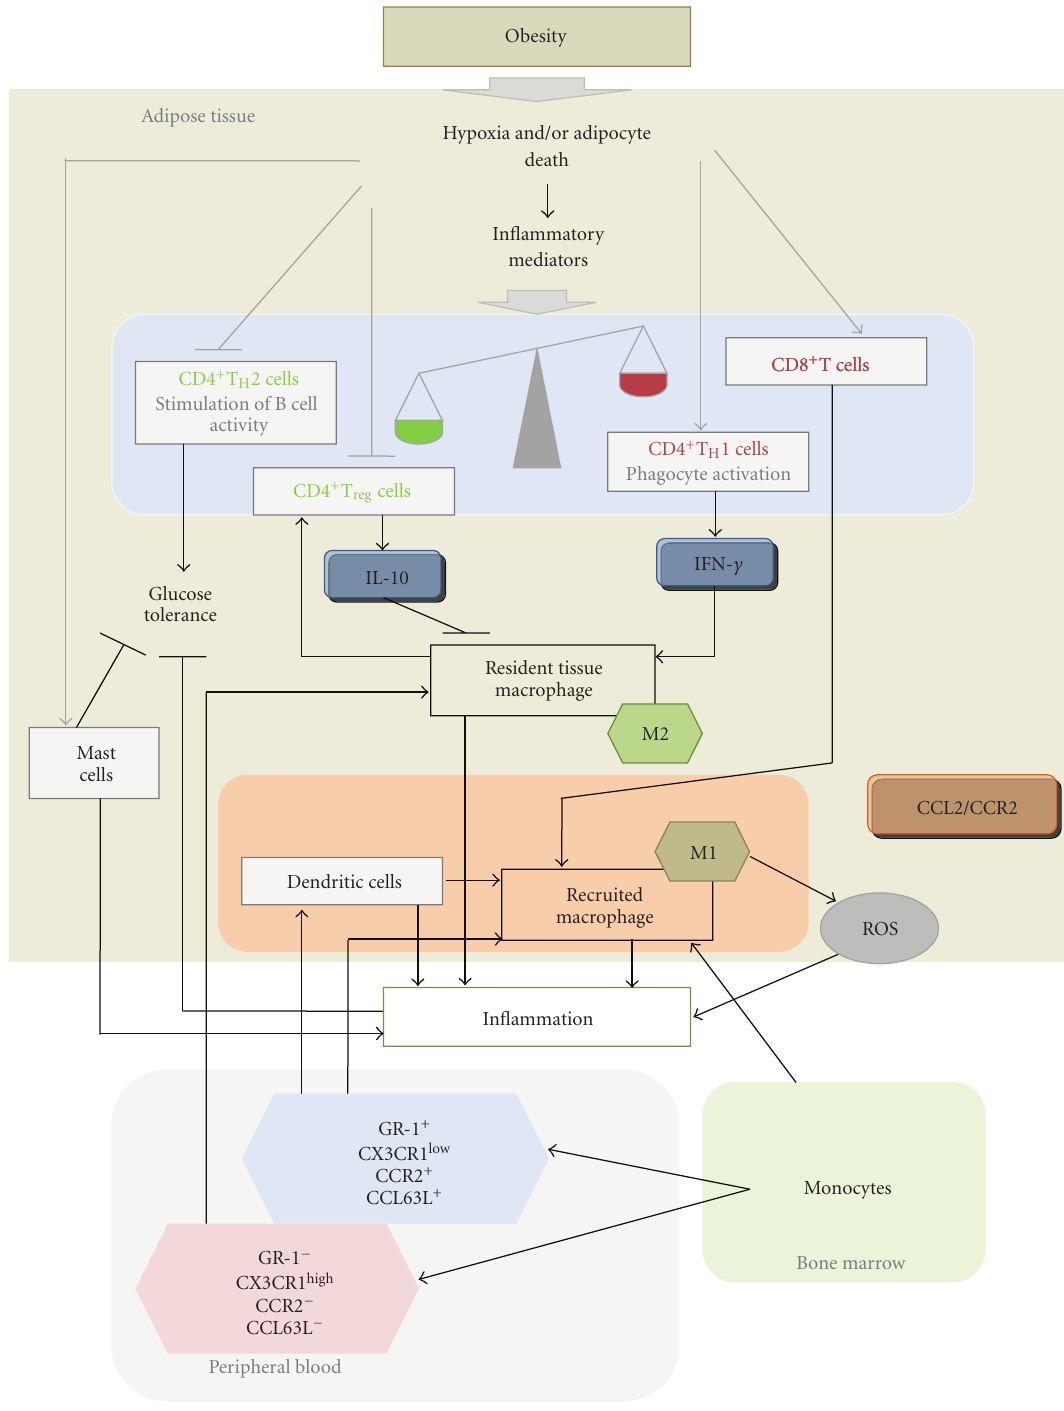
Figure 3: In obesity, immune cells other than macrophages may play a crucial role. To understand the heterogeneous inflammatory properties of adipose tissue macrophages, it is necessary to study the contribution of other immune cells to specific cellular response to metabolic